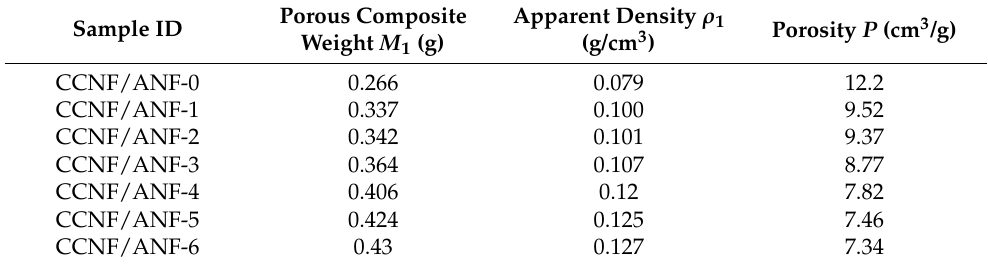
Table 3. Porosity of porous samples.